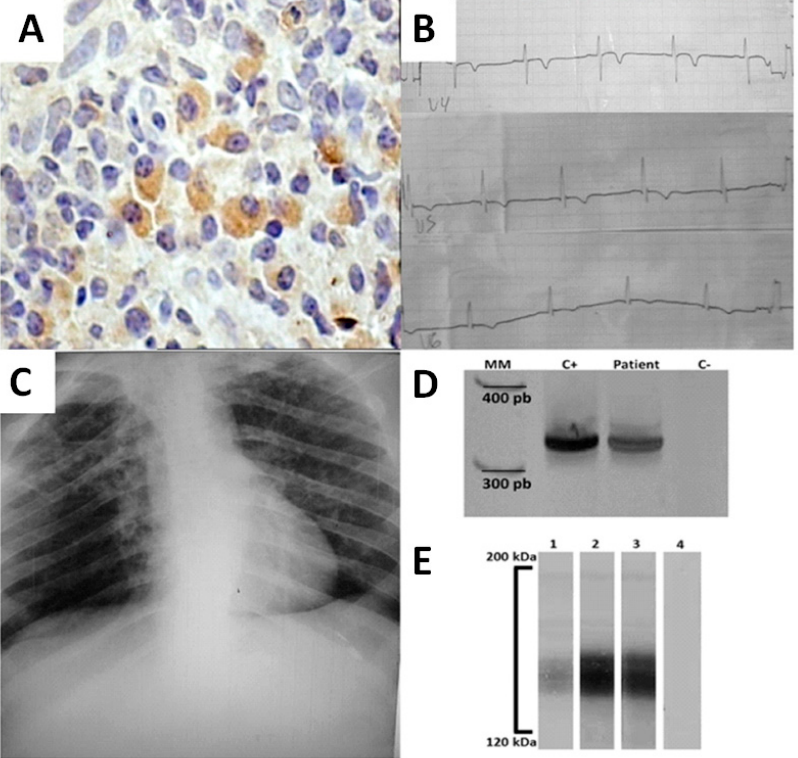
Figure 1. Clinical data and laboratorial findings of a patient with Chagas disease and Leishmaniasis co-infection. ( A ) Immunohistochemistry for the detection of Leishmania’s antigens in nasal septum biopsy. Brown areas indicate the presence of Leishmania sp. antigens ( B ) Electrocardiographic alterations showing V4, V5, and V6 derivations with T-wave inversion indicating chronic chagasic cardiopathy. ( C ) Chest radiography. ( D ) Molecular detection of T. cruzi DNA using specific primers 121–122